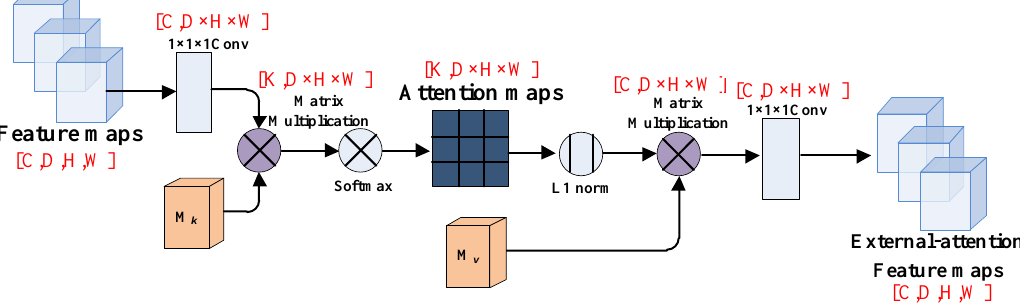
Figure 5. The feature maps in the external-attention module.